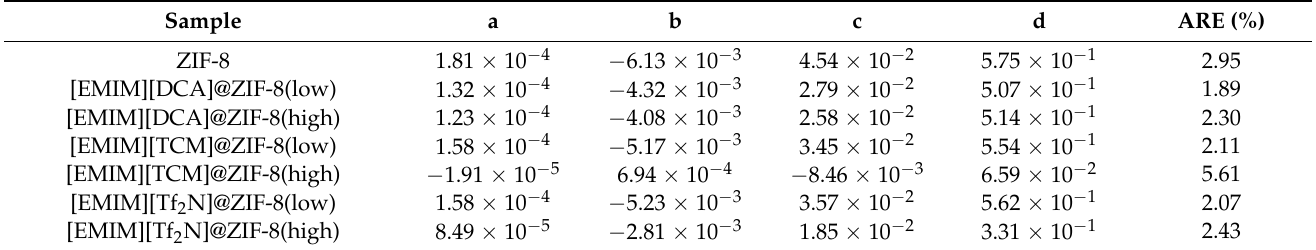
Table A2. CO 2 coefficient parameters and global average relative error of the fitting using Equation (3).